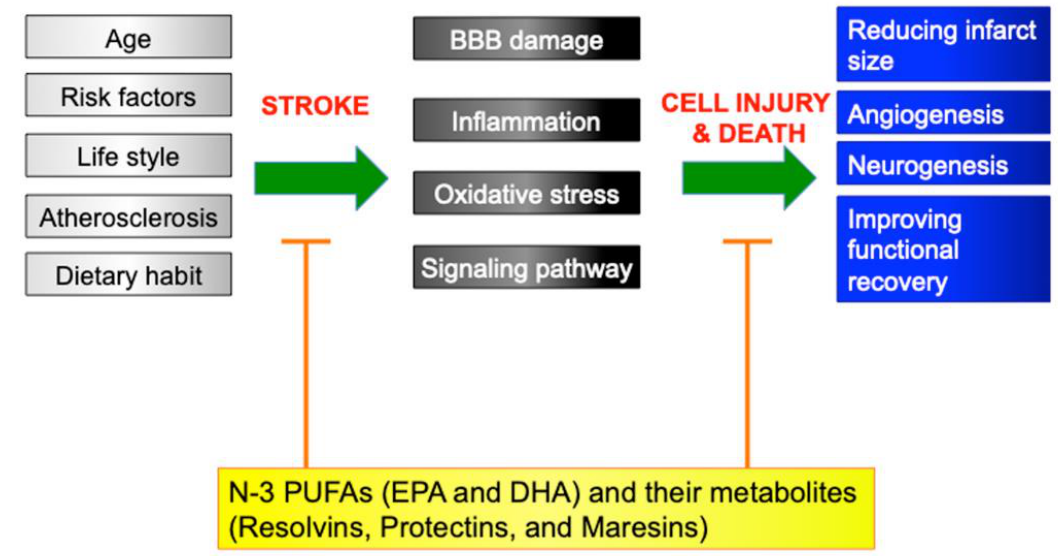
Figure 3. Scheme of underlying mechanisms before and after stroke. Age, cardiovascular risk factors, atherosclerosis, lifestyle, and dietary habits could be implicated in the mechanisms of stroke development in humans. On the other hand, previous experimental studies showed that the blood–brain barrier (BBB), inflammation, oxidative stress, and pathologic signaling pathways contributed to the mechanisms after stroke. N-3 polyunsaturated fatty acids including eicosapentaenoic acid (EPA) and docosahexaenoic acid (DHA), and its metabolites, resolvins, protectins, and maresins, suppressed these pathomechanisms, and reduced infarct size, induced angiogenesis and neurogenesis, and improved functional recovery. Bar-headed lines indicate an inhibition, and arrows represent a production and induction.